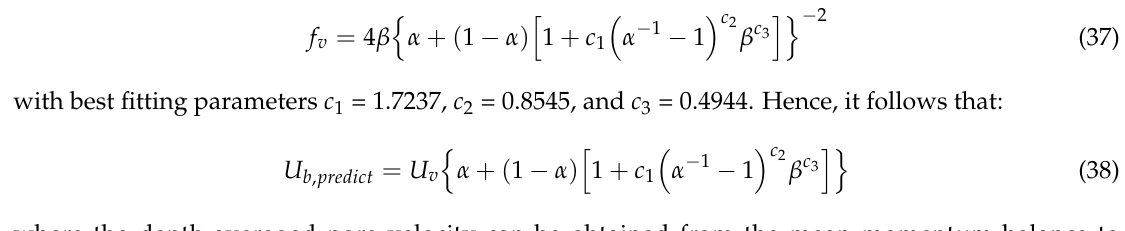
Figure 4. Relationship between ∆ U / U v and β from the numerical model.